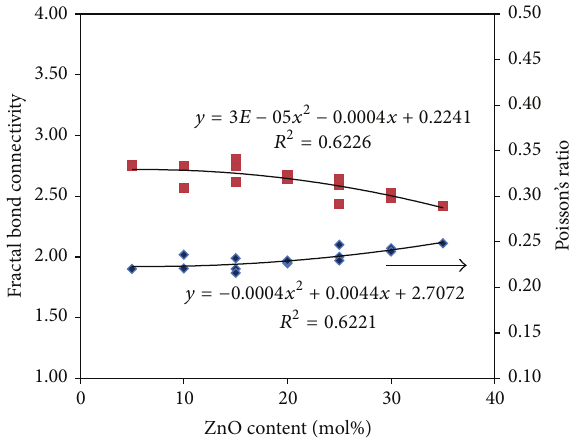
Figure 4: Variation of Poisson’s ratio and fractal bond connectivity of ZOT glass series at various ZnO